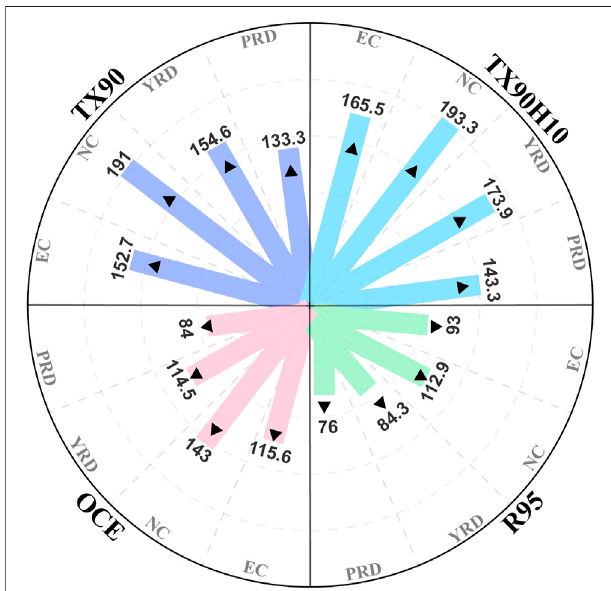
FIGURE 2 | Area-averaged MDA8 O 3 concentrations (unit: μ g m − 3 ) corresponding to TX90, TX90H10, R95, and OCE during the summers of 2015 – 2021 in East of China (EC), North China (NC), the Yangtze River Delta (YRD), and the Pearl River Delta (PRD). The numbers represent ozone concentrations. The results from GEOS-Chem simulations were denoted by solid triangles on the bars.